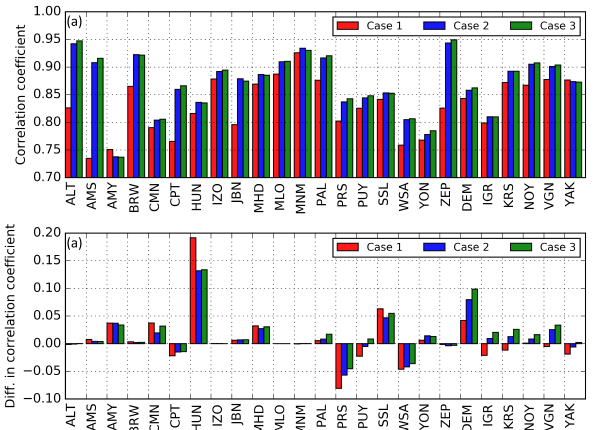
Figure 5. (a) Standard deviation (SD) for the CO 2 concentra- tion model–observation mismatch when using the coupled model, (b) difference in SD due to the application of Lagrangian compo- nent (negative values mean the results of the coupled model are bet- ter than of the Eulerian model alone) at the selected WDCGG and JR-STATION locations for 2009–2010. The definitions of the cases 1–3 are in Table